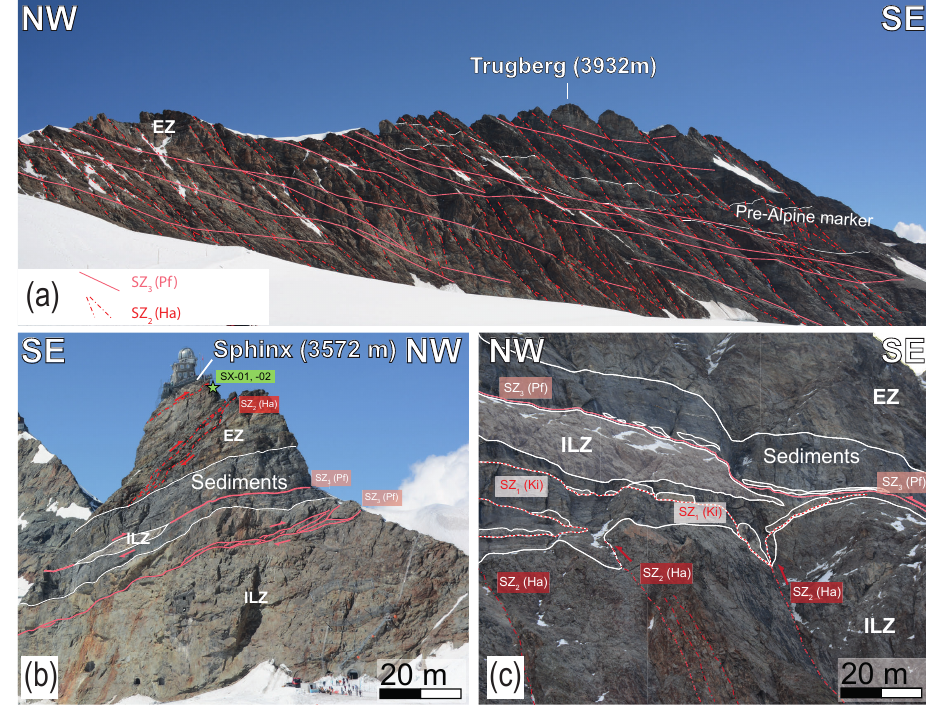
Figure 5. Deformation structures in the basement on the large scale in different key outcrops along the strike of the mountain chain (localities are indicated in Fig. 2). (a) Trugberg mountain ridge viewed from the west: the complex shear zone network with indication of the individual deformation-phase structures Pf: Pfaffenchopf phase, Ha: Handegg phase (see also Fig. 6). (b) The Jungfrau sediment wedge (JSW) from the east with an incorporated large basement wedge that separates the Innertkirchen–Lauterbrunnen zone (ILZ) from the Erstfeld zone (EZ). (c) Late stage shear zoning below the Jungfrau demonstrating the complex cross-cutting and overprinting relationship of the different structures (Ki: Kiental phase). For deformation phase discussion and attribution, see discussion in text. Location of key samples is indicated (SX-01, SX-02).